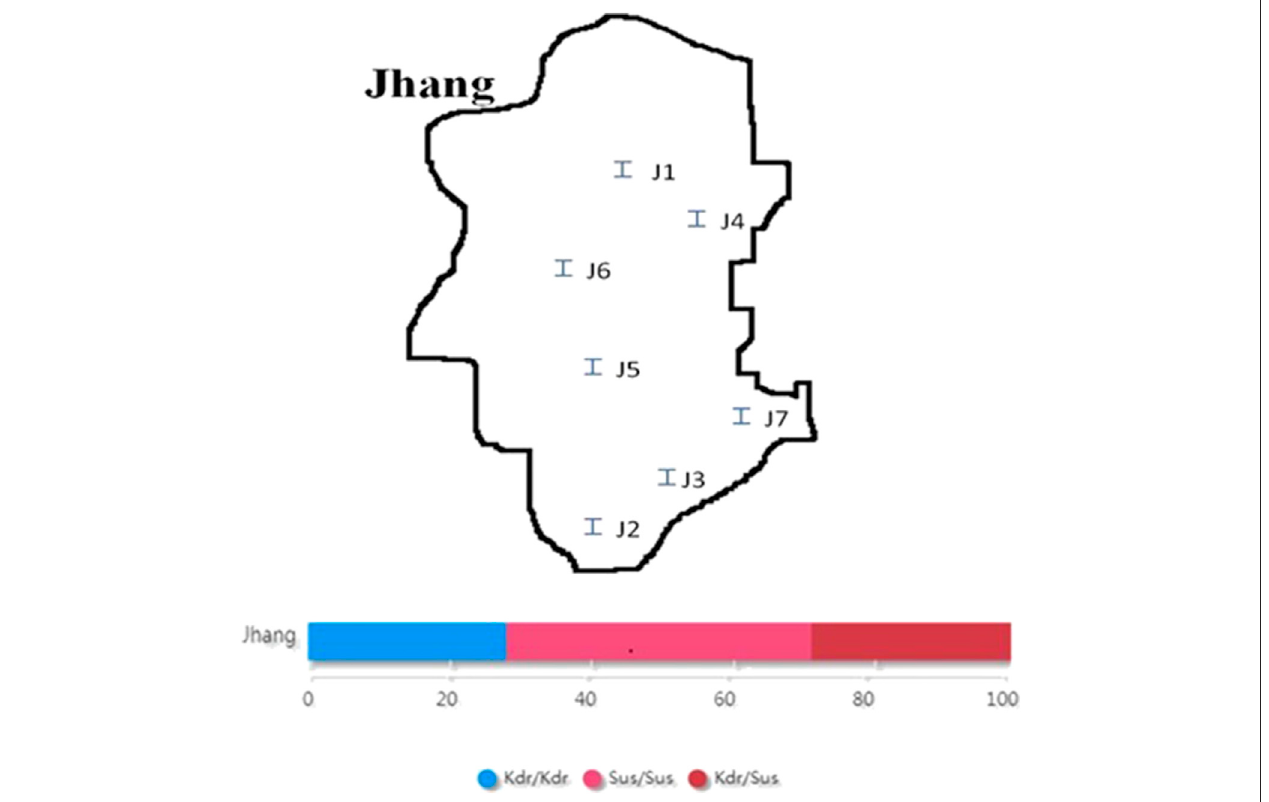
FIGURE 2 | Map of District Jhang and frequency of homozygous sus/sus, heterozygous kdr/sus, and homozygous kdr/kdr loci. J1: Civil lines; J2: 18-Hazari; J3: Head trimu; J4: Nawaz chowk; J5: Malhumorr; J6: Sattelite town; J7: Haveli bahadur.